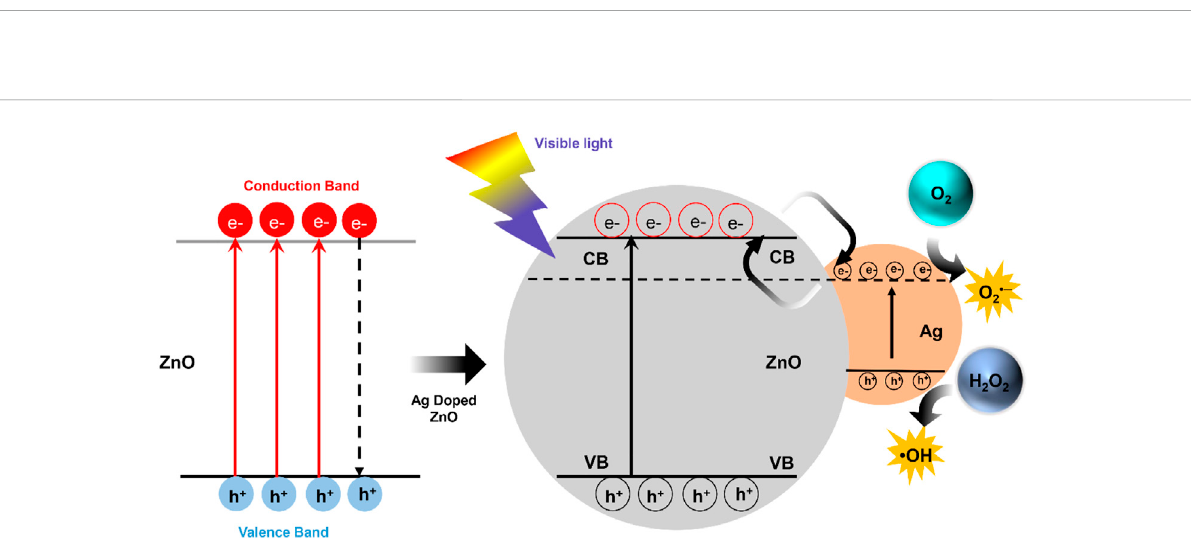
FIGURE 3 Schematic representation of the movement of electrons in ZnO@Ag under visible light.